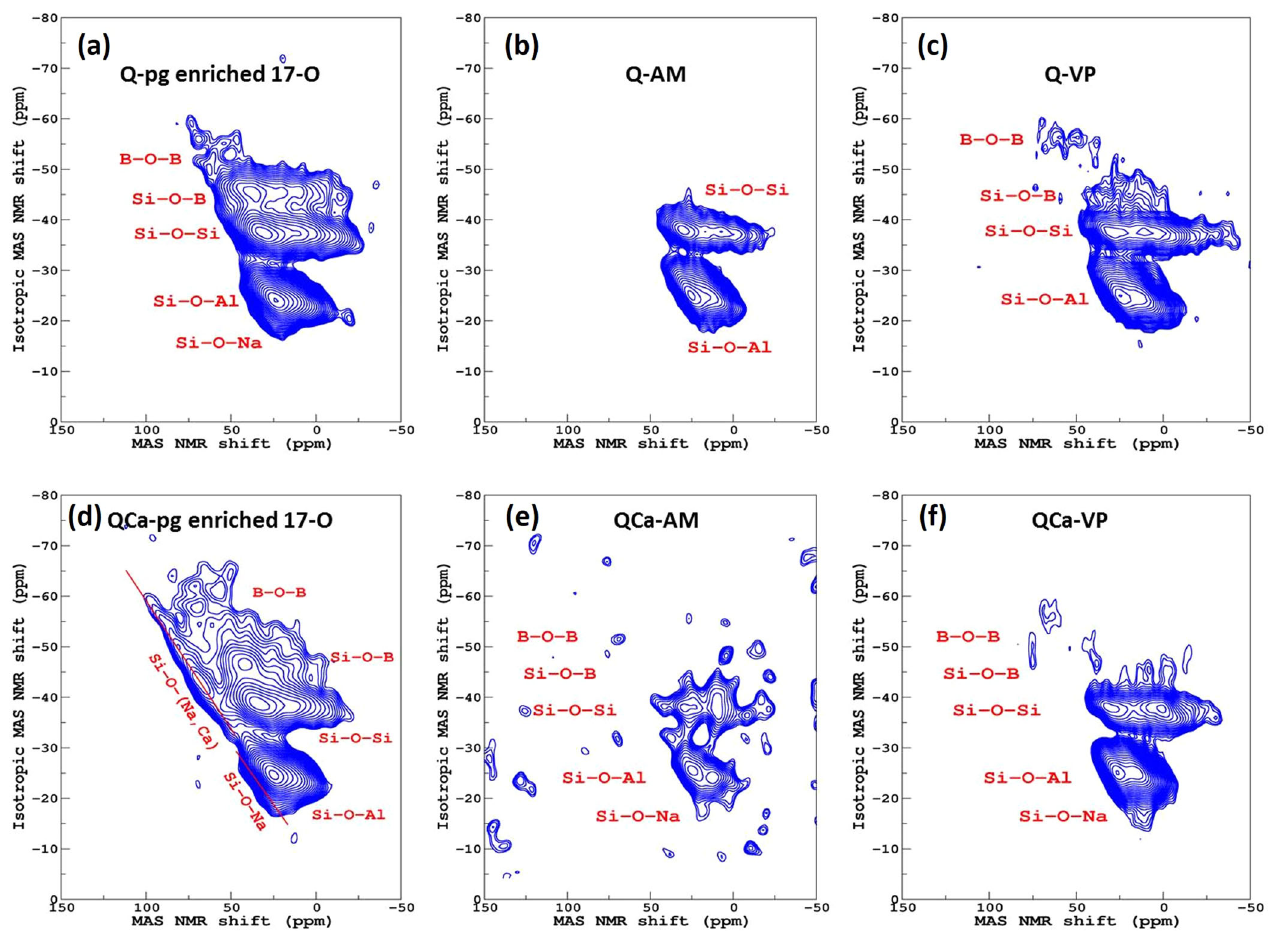
Fig. 4 17 O MQMAS NMR spectra. a pristine Q glass enriched in 17 O (Q-pg enriched 17-O); b unenriched Q glass altered in 17 O-enriched aqueous medium (Q-AM); c unenriched Q glass altered in 17 O-enriched vapor phase (Q-VP); d pristine QCa glass enriched in 17 O (QCa-pg enriched 17-O); e unenriched QCa glass altered in 17 O-enriched aqueous medium (QCa-AM); f unenriched QCa glass altered in 17 O-enriched vapor phase